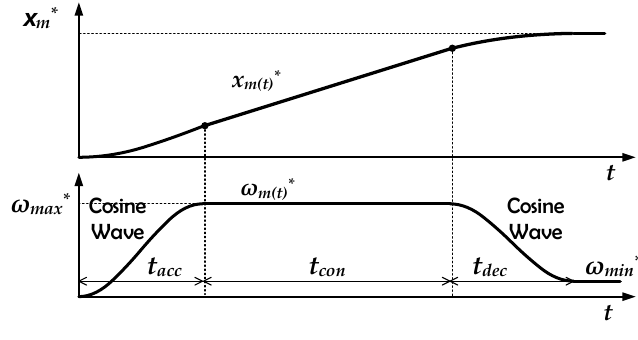
Figure 8. Proposed cosine acceleration speed reference model.